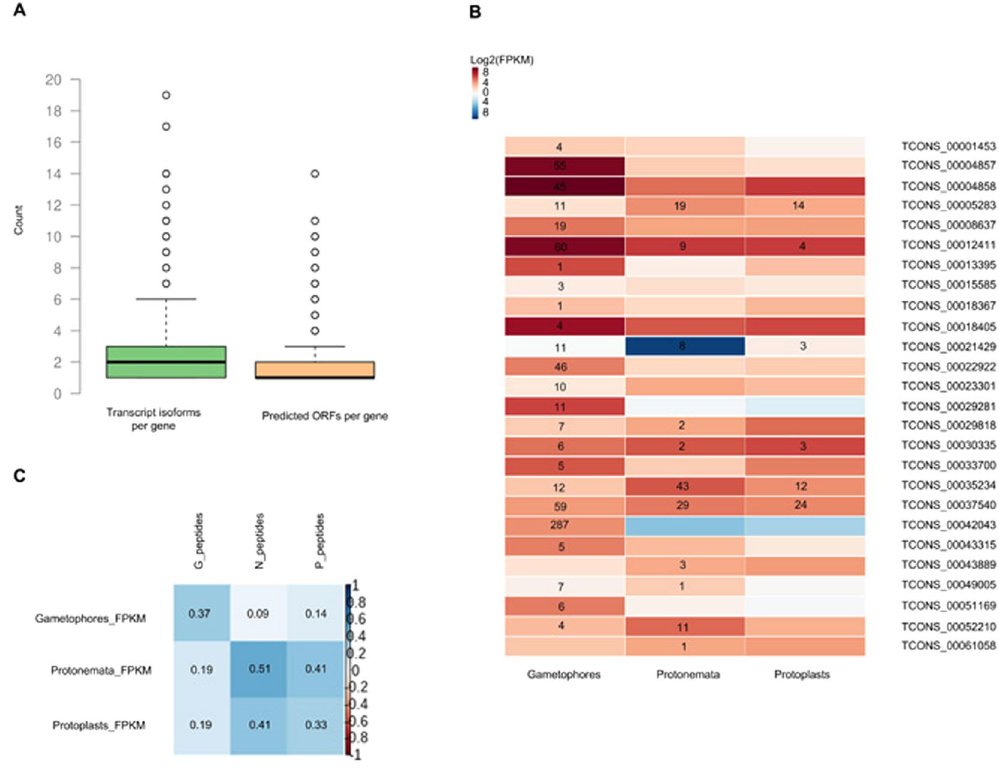
Figure 3. ( A ) Bar plot showing the distribution of the number of transcript isoforms and predicted ORFs per gene. ( B ) Heatmap representing the levels of isoform transcripts of 25 differentially alternatively spliced (DAS) genes. Digits indicate the number of spectra from isoform-specific peptides. ( C ) Heatmap reports the correlation between the level of transcription of alternative isoforms and the normalized values of spectra from isoform-specific peptides for gametophores (Gametophores_FPKM-G_peptides), protonemata (Protonemata_ FPKM-N_peptides) and protoplasts (Protoplasts_FPKM-P_peptides); digits indicate Spearman correlation